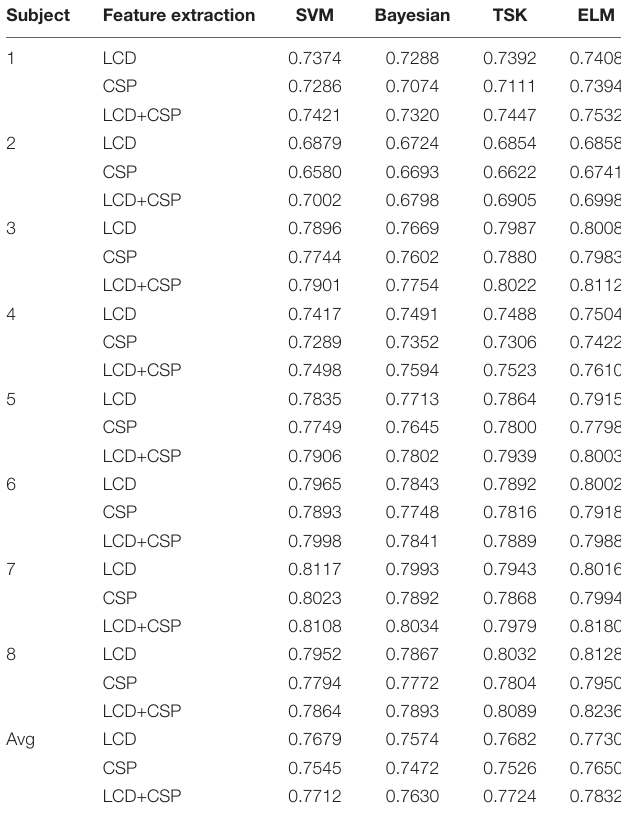
TABLE 2 | Classification accuracy of data sets IIb.